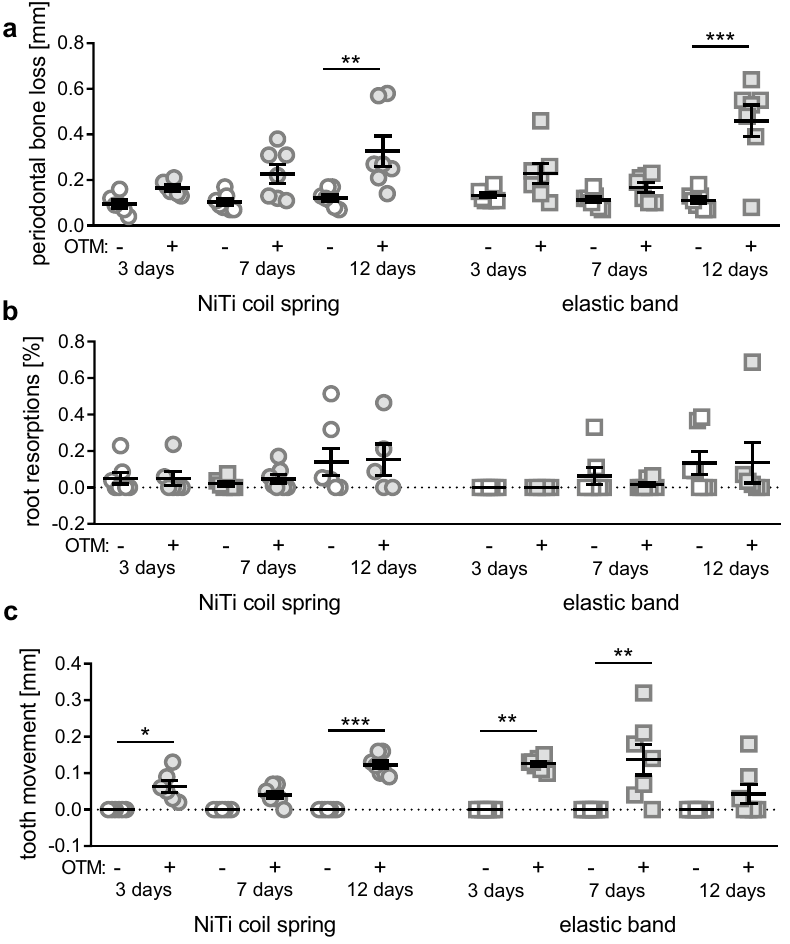
Figure 4. Periodontal bone loss ( a ), orthodontically induced inflammatory root resorptions ( b ) and extent of experimentally induced orthodontic tooth movement ( c ) after three, seven or 12 days of OTM with a NiTi coil spring or an elastic band compared to the untreated contralateral jaw side, at which tooth movement was always 0 mm. * p ≤ 0.05, ** p ≤ 0.01, *** p ≤